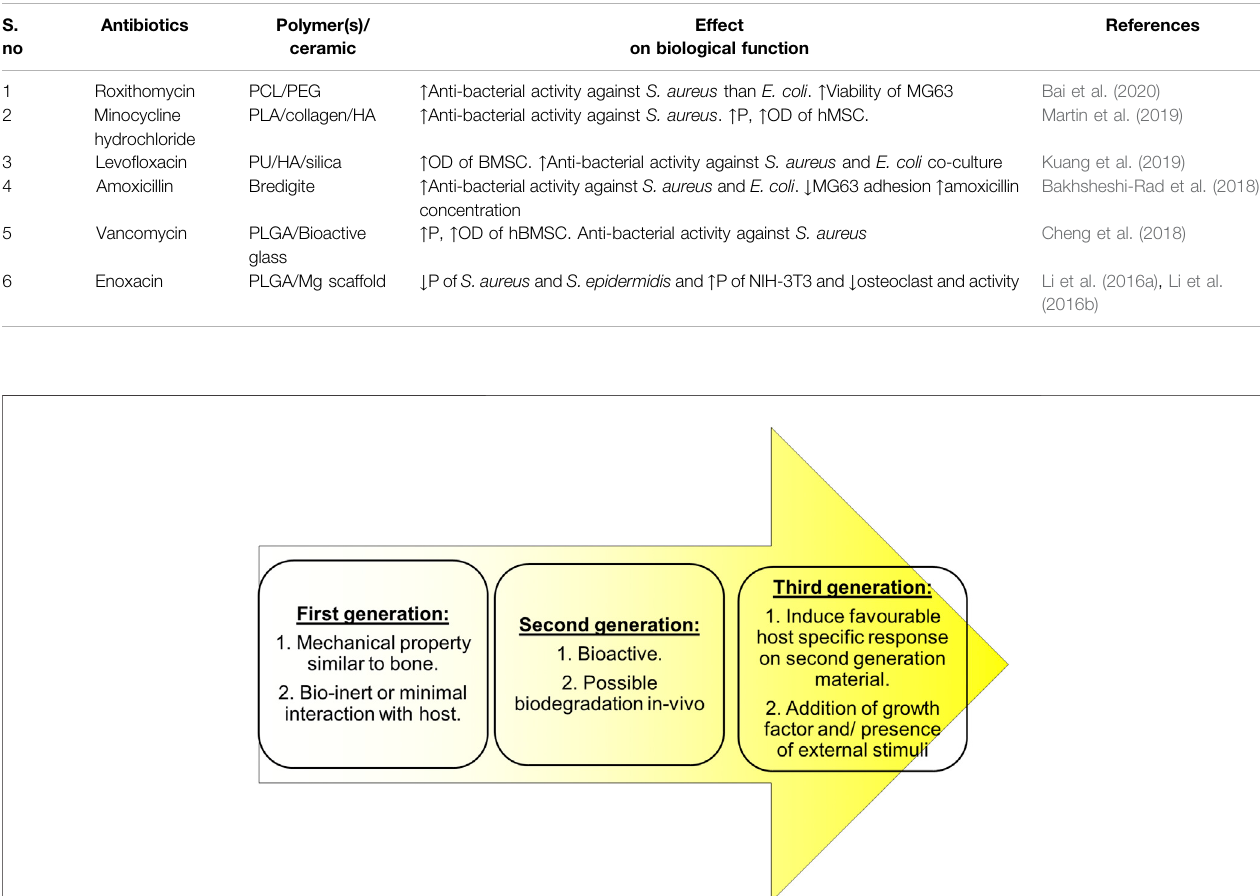
FIGURE 1 | Properties considered while choosing biomaterials for scaffold over generations (Qu et al., 2019).